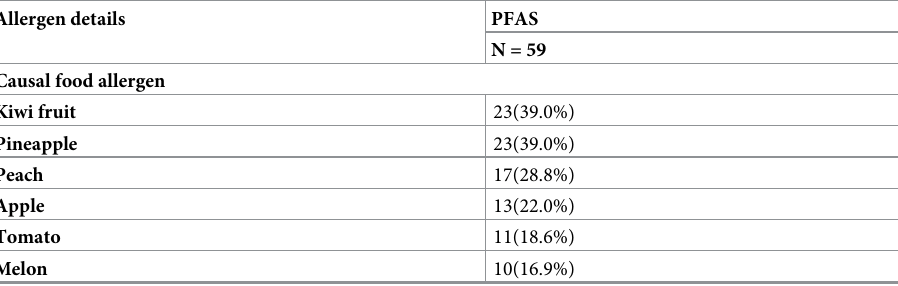
Table 8. Causal food allergen according to OAS and